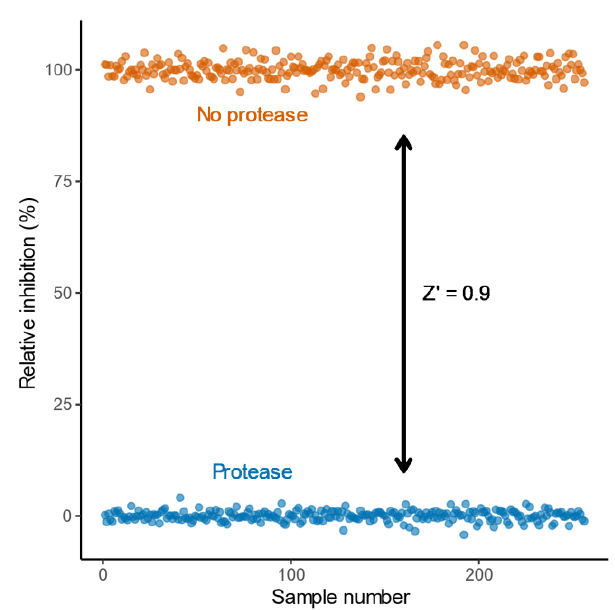
Figure 3. Separation of the positive and negative controls used to calculate relative inhibition of protease. Relative inhibition was calculated using the average R 528 / 477 for the protease treated controls as 0% inhibition and the average R 528 / 477 for untreated controls as 100% inhibition. The data are the 256 no protease controls and 256 protease controls collected from all plates when screening the LOPAC ® 1280 in duplicate. All datapoints are shown.